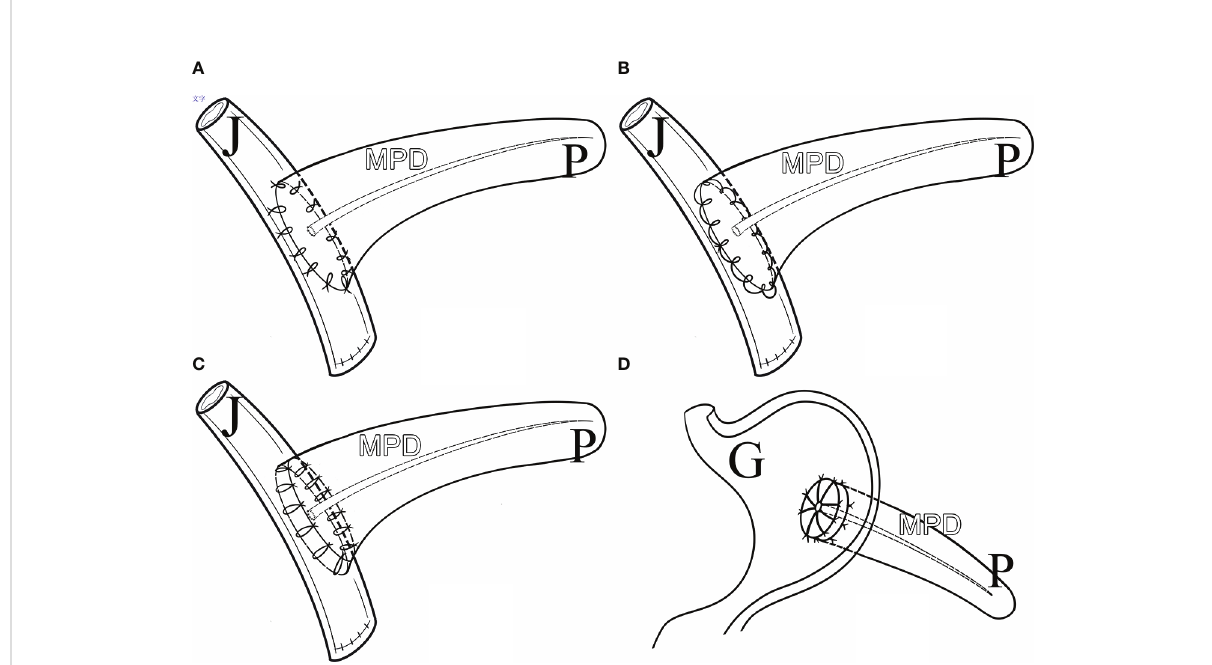
FIGURE 3 Pancreatic Anastomosis Techniques. (A) Duct to Mucosa PJ (Interrupted Suture). (B) Duct to Mucosa PJ (Continuous Suture). (C) Duct to Mucosa “ HO ” half-purse binding PJ. (D) Invaginating PG. P, pancreas; J, jejunum; G, gastro; MPD, main pancreatic duct.